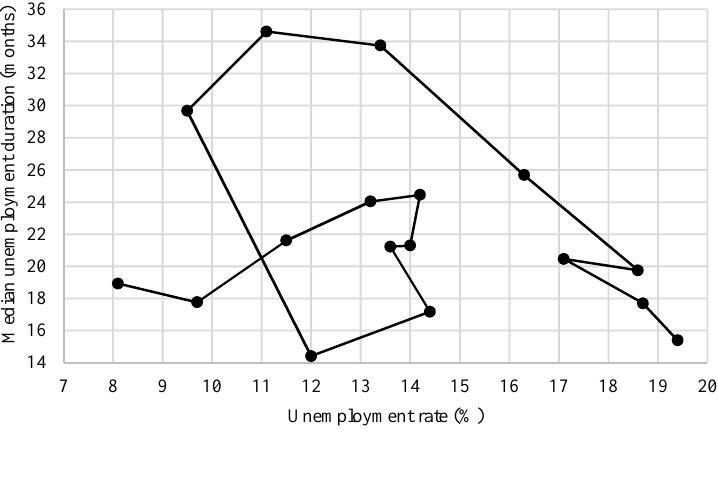
Figure 6. Relation between the unemployment rate and the median unemployment duration in Slovakia in years 2001–2017